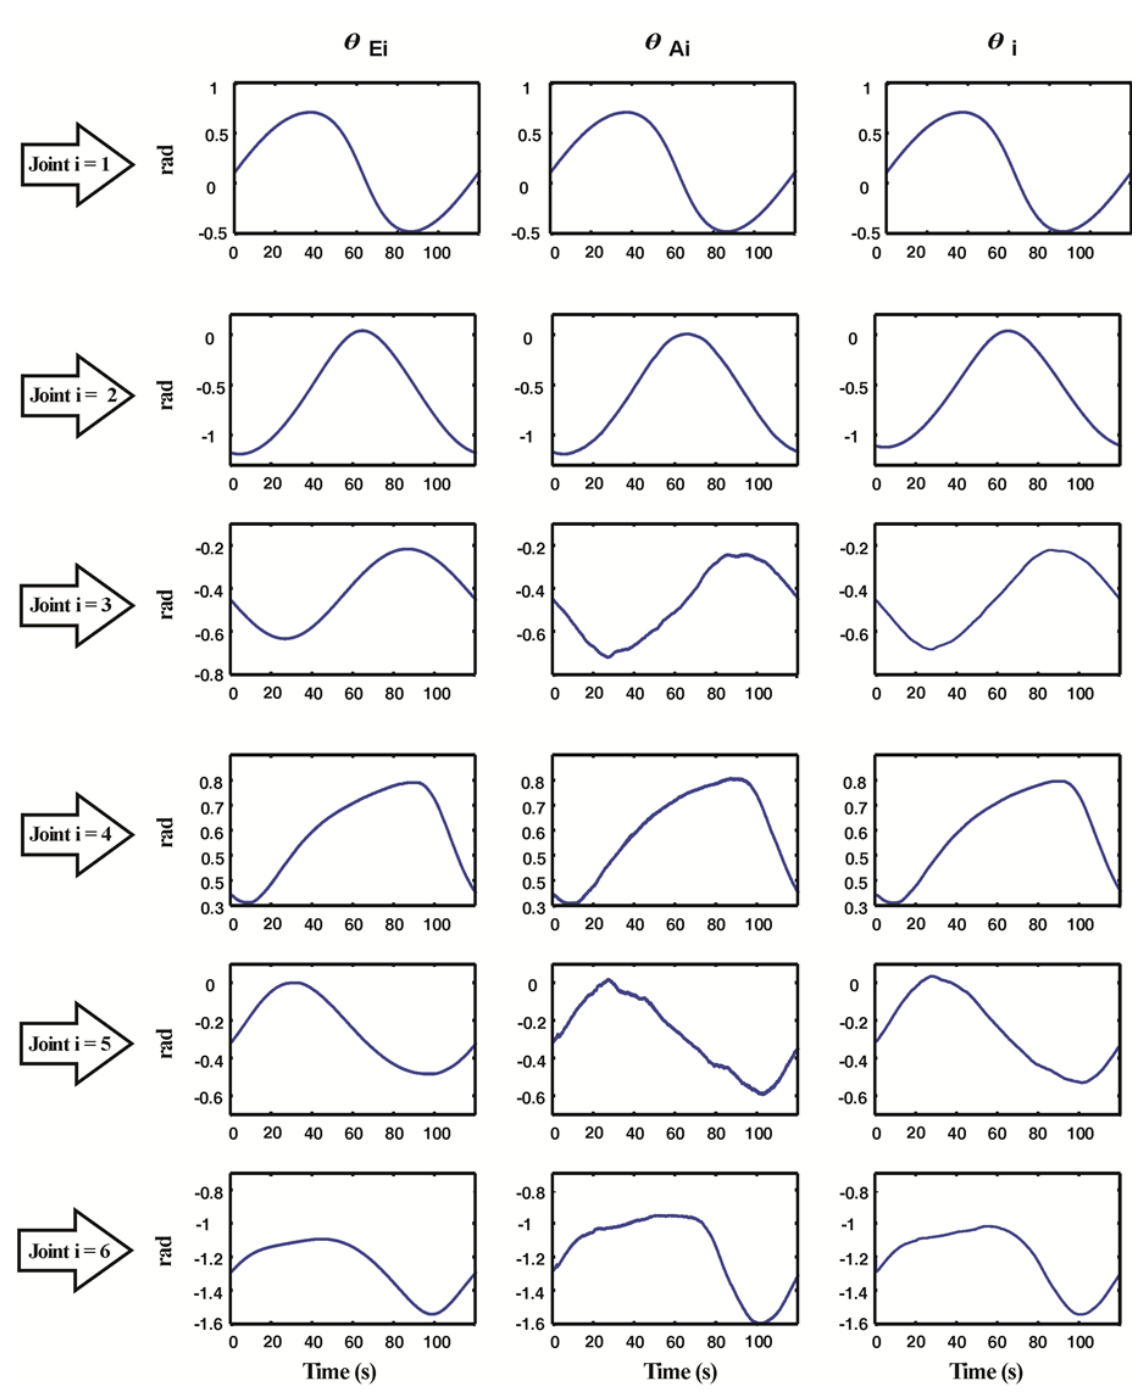
Figure 10. Angular position obtained with accelerometer and encoder, and fused